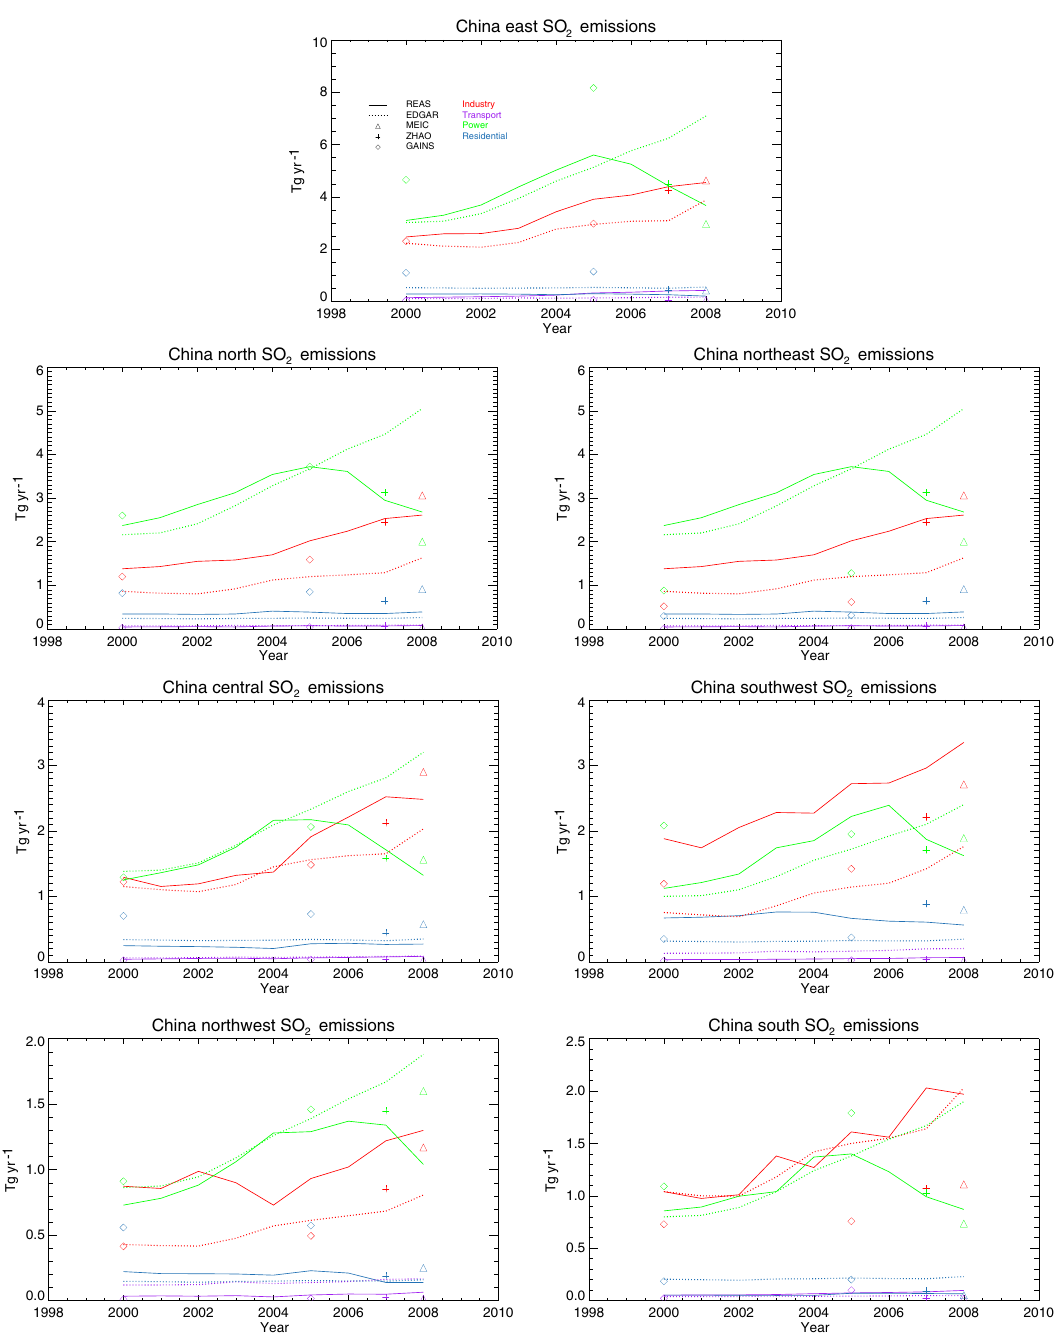
Figure 7. Regional total emissions for SO 2 for four different source sectors (industry, transport, power, and residential) estimated by REAS, EDGAR, MEIC, ZHAO, and GAINS between 2000 and